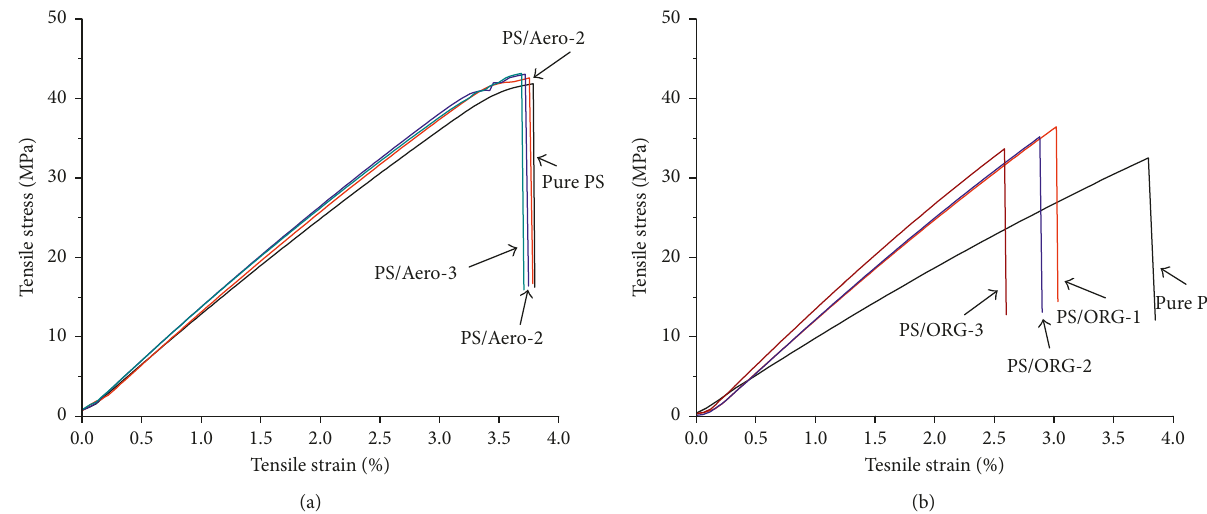
Figure 9: Stress-strain curves of PS/clay nanocomposites prepared from the nanoclay aerogel masterbatch and organoclay.